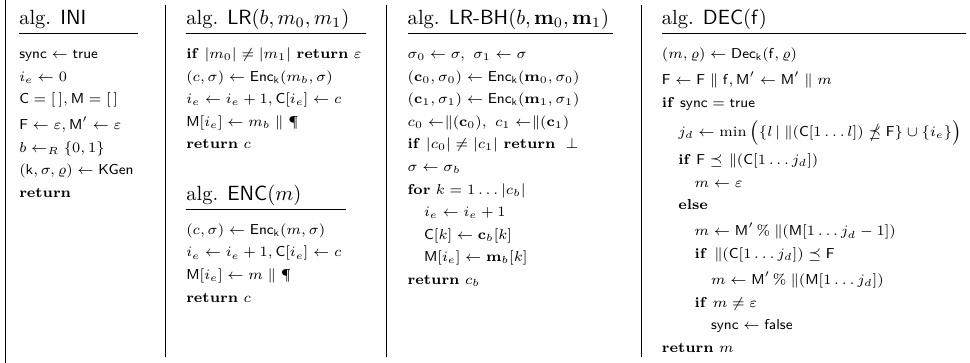
Figure 6: Algorithms for defining IND - sfCFA , IND - sfCTF , BH - CPA and BH - sfCFA advan-